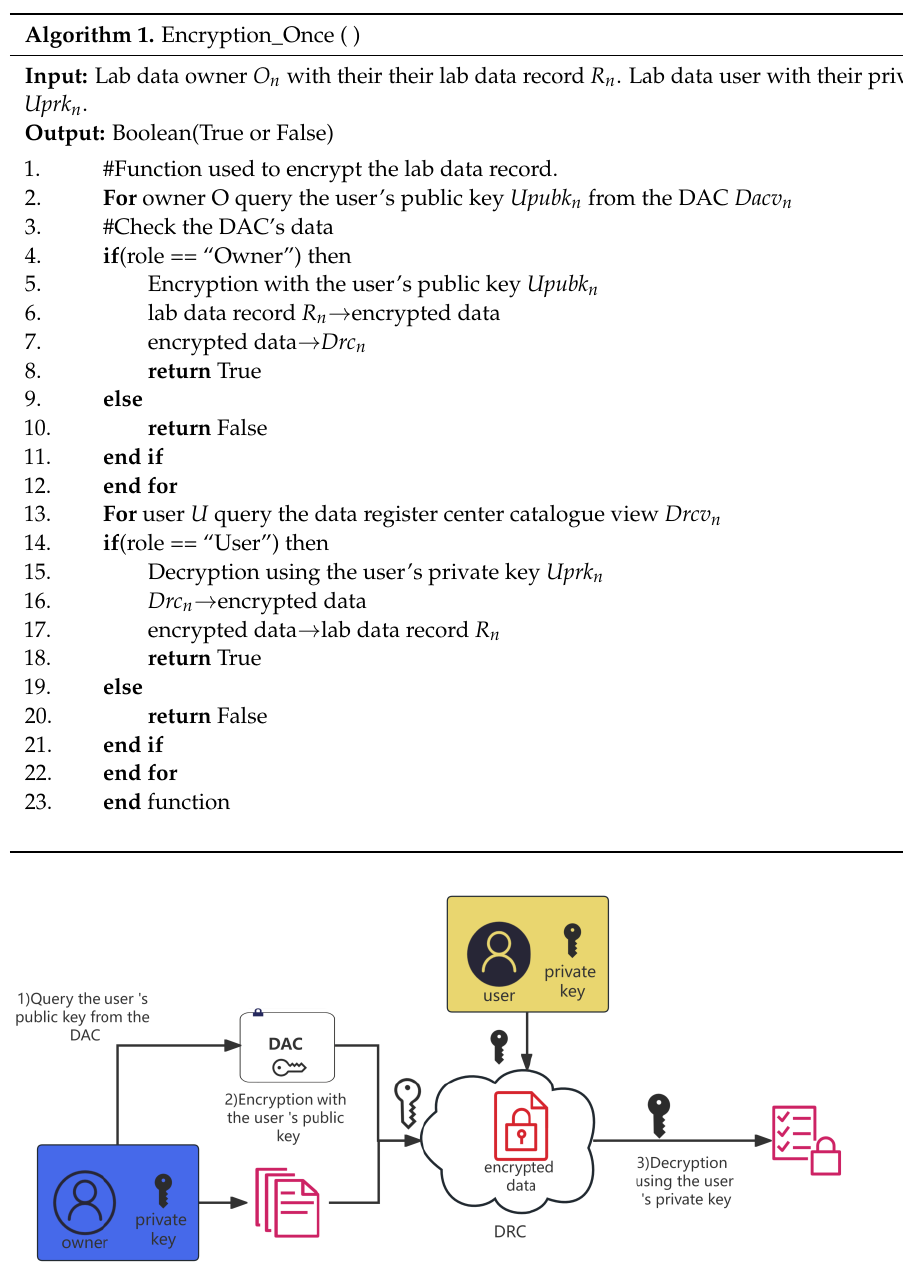
Figure 4. Single-layer encryption. Table 3. The definition of symbols used. Algorithm 1. Encryption_Once ( )